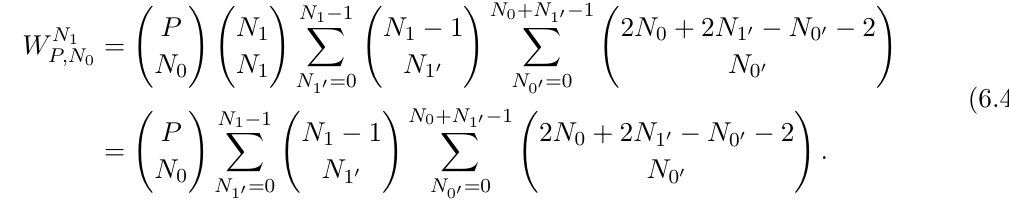
Figure 12 . (Color online.) Simpli(cid:12)ed basis of a multi- (cid:28) (cid:22) (cid:28) Hilbert space on a surface with N gapped boundaries. This is three dimensional picture. The vertical columns with solid boxes and the right most column are vacancy boxes for pseudo-species 0 0 , as in the disk case. The left most vertical column with one solid and one dashed box and the horizontal columns (in red) are the vacancy boxes for pseudo-species 1 0 . Duplicate boxes (dashed) are